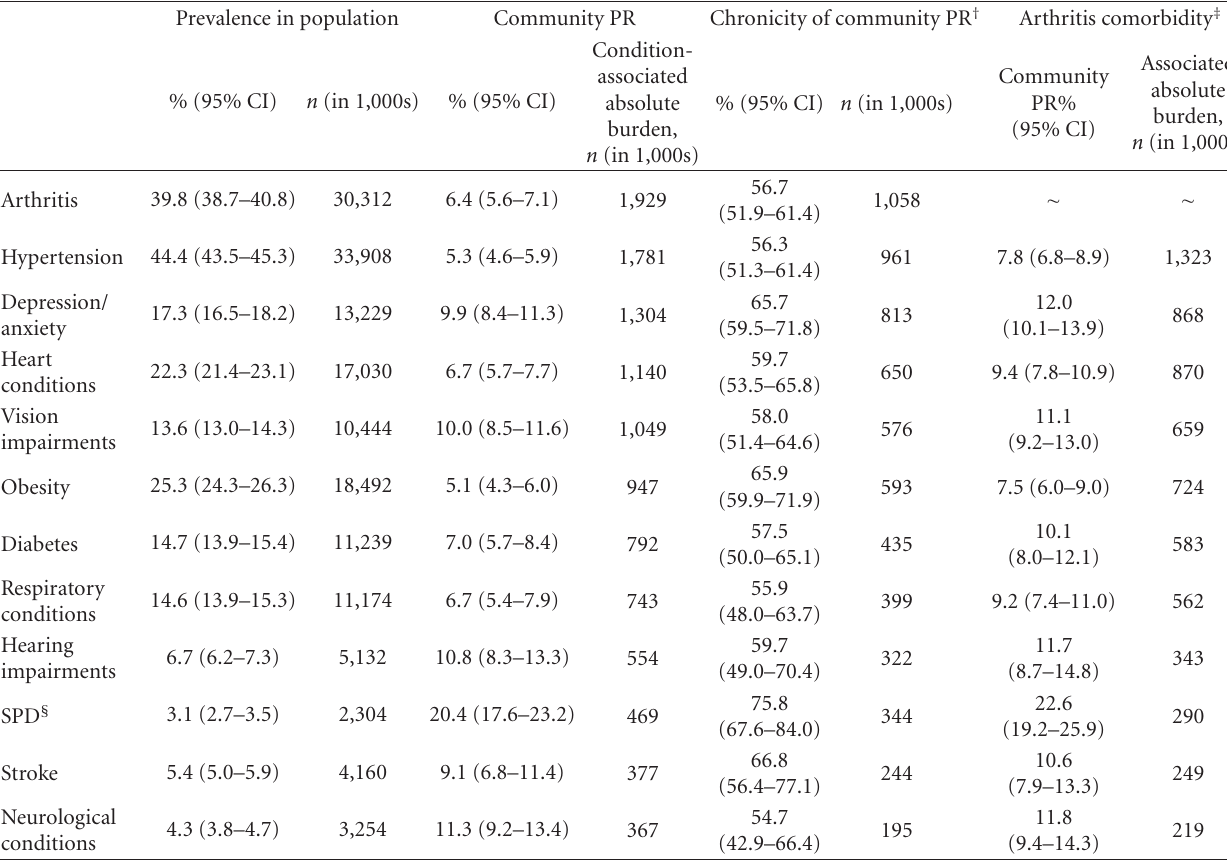
Table 2: Weighted estimates and 95% confidence intervals (95% CI) of prevalence of selected chronic conditions; community participation restriction (PR) and condition-associated absolute burden; chronicity of community PR; arthritis comorbidity and associated absolute burden among adults ≥ 50 years with selected chronic conditions, 2002.